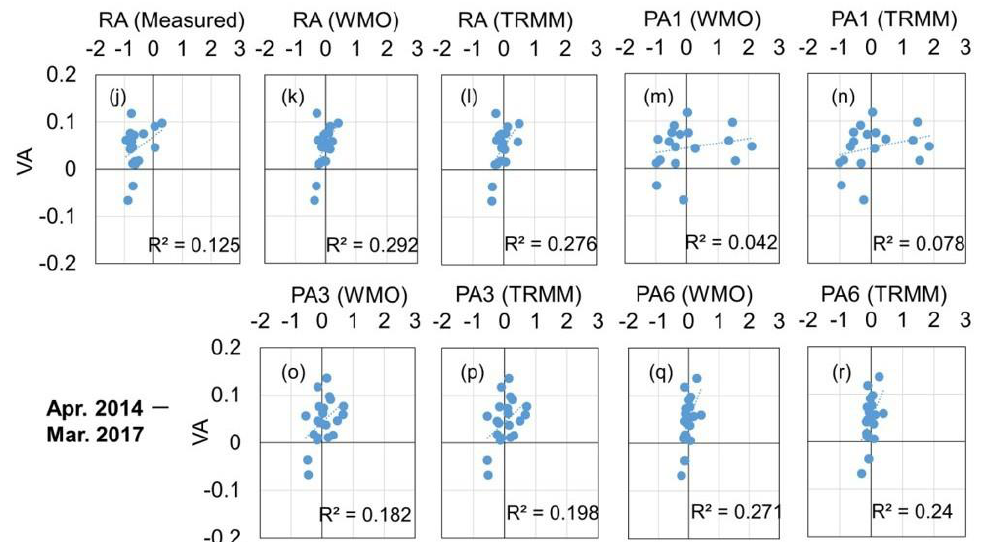
Figure 7. The correlation of leaf area index (LAI) anomaly (VA) with runoff anomaly (RA) and multi-temporal precipitation anomaly (PA) during ( a – i ) 2003–2008 and ( j – r ) 2014–2017.